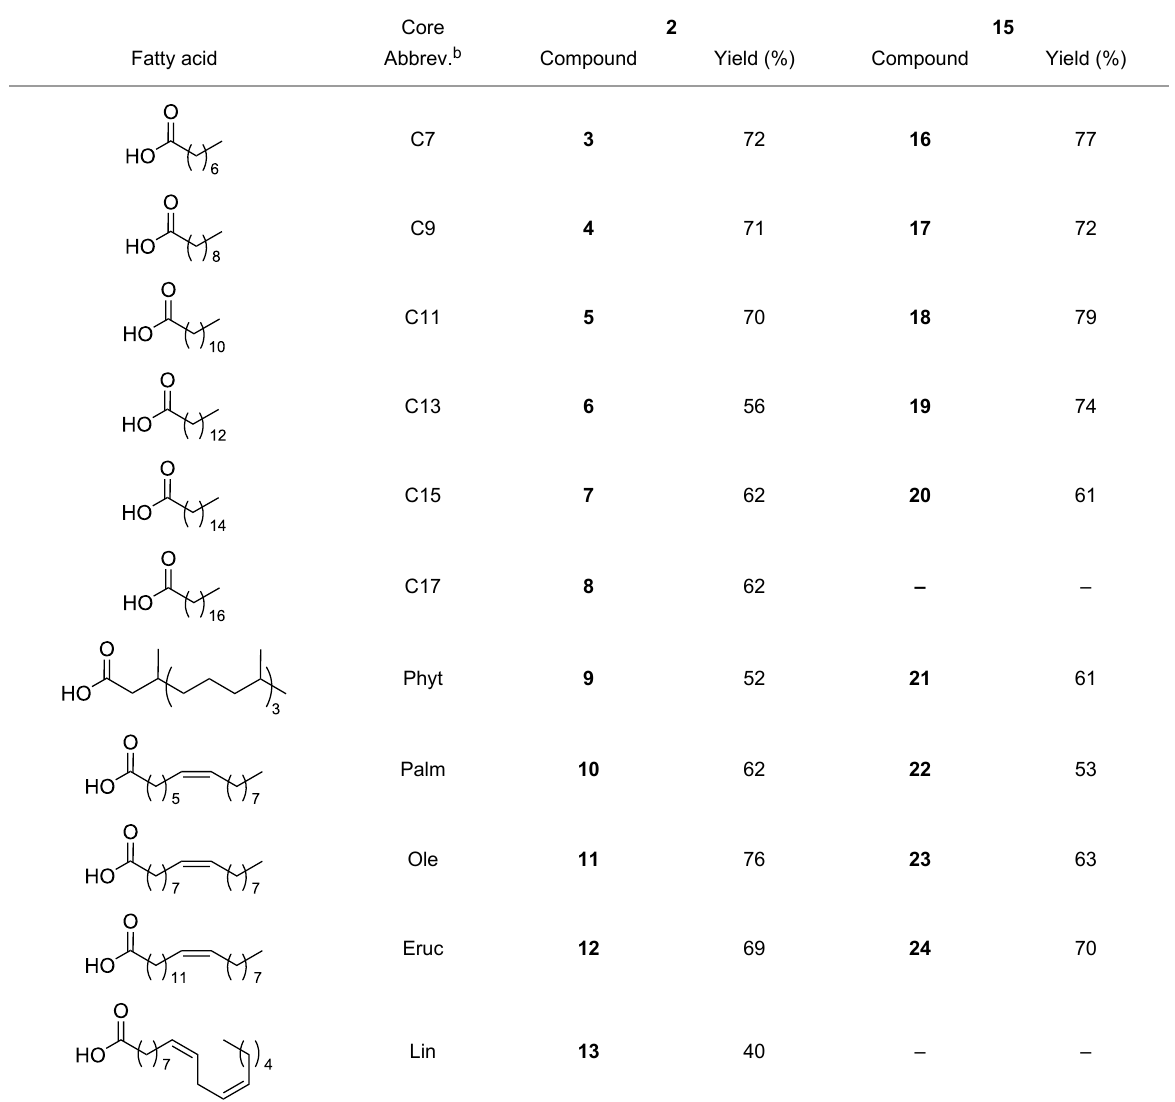
Table 1: Double and triple-chain alkyne-tethered tails synthesised.